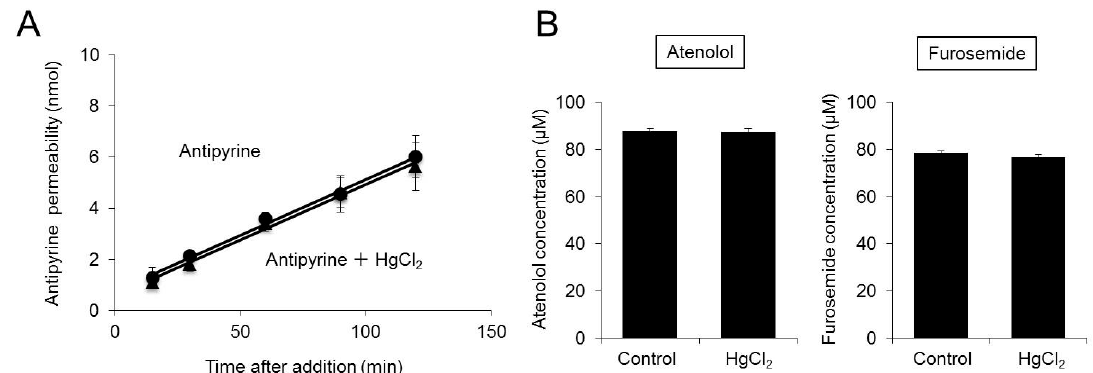
Figure 3. Effect of inhibition of AQP3 function on permeability to various drugs. Caco-2 cells were plated in Transwell plates and incubated for 21 days. ( A ) Antipyrine alone or a combination of antipyrine and HgCl 2 was added to the apical side of the Transwell plate. The concentration of antipyrine on the basal side was measured. ( B ) Atenolol alone or a combination of atenolol and HgCl 2 was added to the apical side of the Transwell plate. Furosemide alone or a combination of furosemide and HgCl 2 was added to the apical side of the Transwell plate. At 120 min after addition, the concentration of atenolol or furosemide on the apical side was measured. The data are presented as the mean ± SD for six experiments.